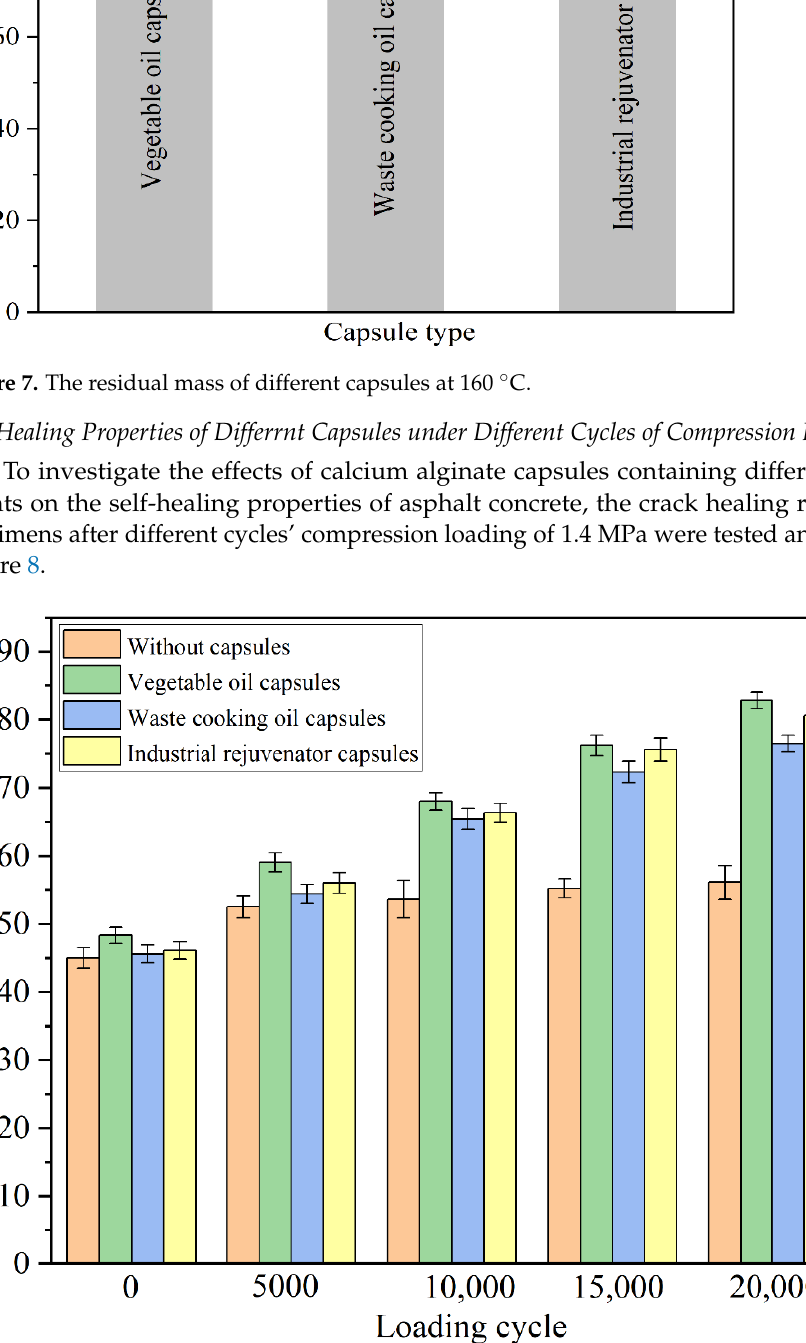
Figure 8. Strength recovery ratios of the fractured specimens containing different capsules after different cycles of compression loading at 1.4 MPa.